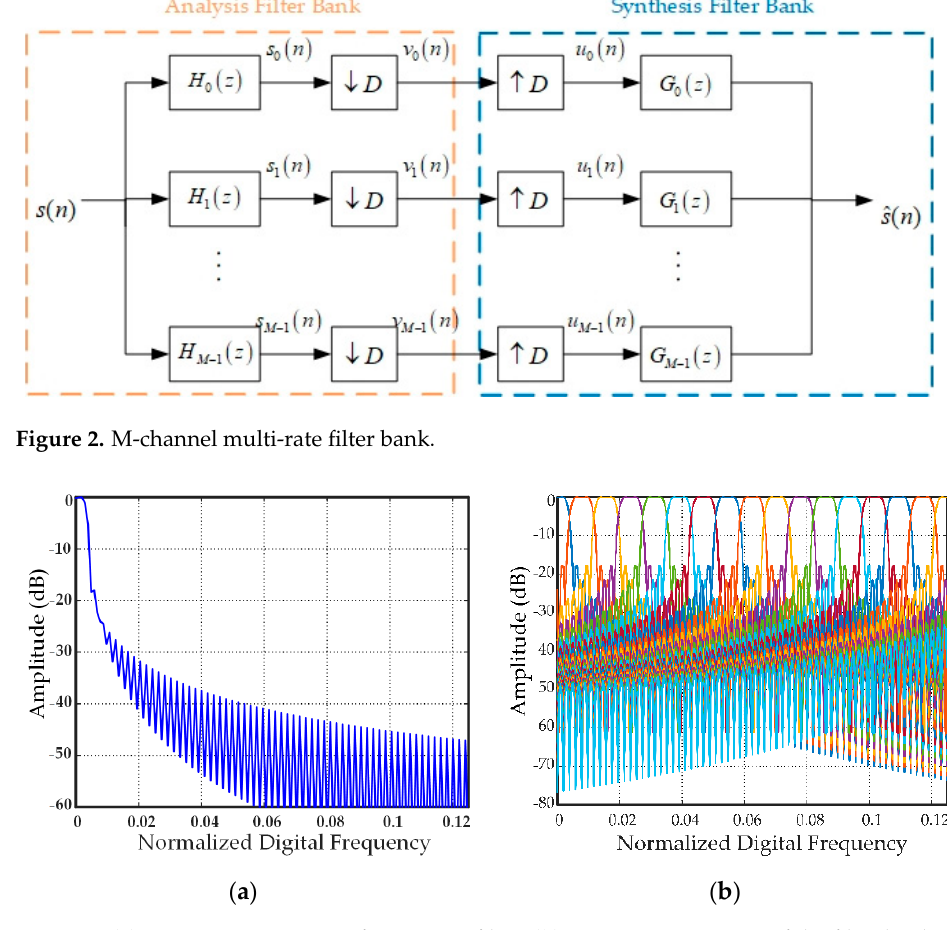
Figure 3. ( a ) Frequency response of prototype filter; ( b ) Frequency response of the filter bank.